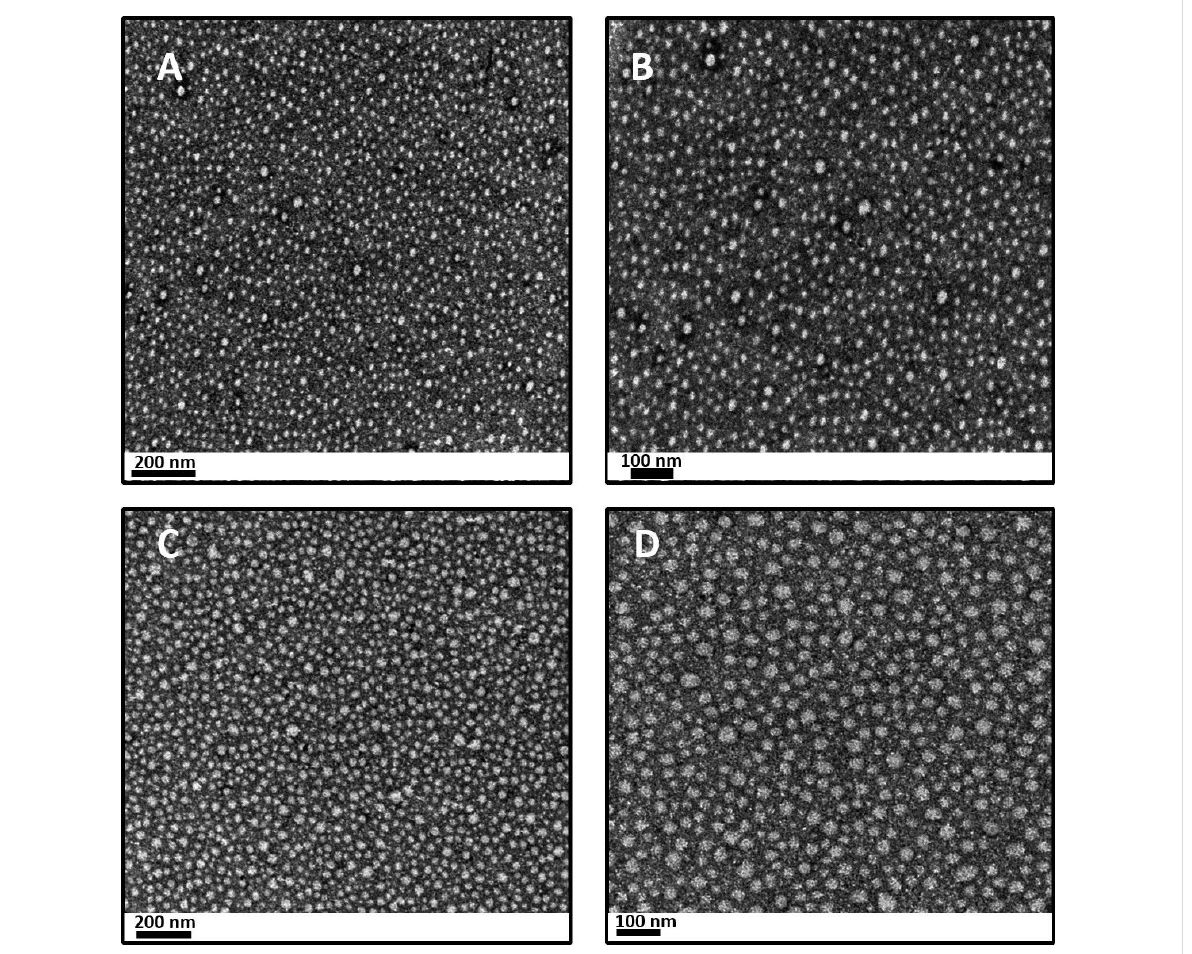
Figure 5: TEM images of nanostructured systems at 37 °C demonstrating the individual micellar organization: (A) and (B) represent the nanostruc- tured systems in the absence of CUR, scale bar equals to 200 and 100 nm, respectively. (C) and (D) represent the nanostructured systems contain- ing CUR, scale bar equals to 200 and 100 nm,